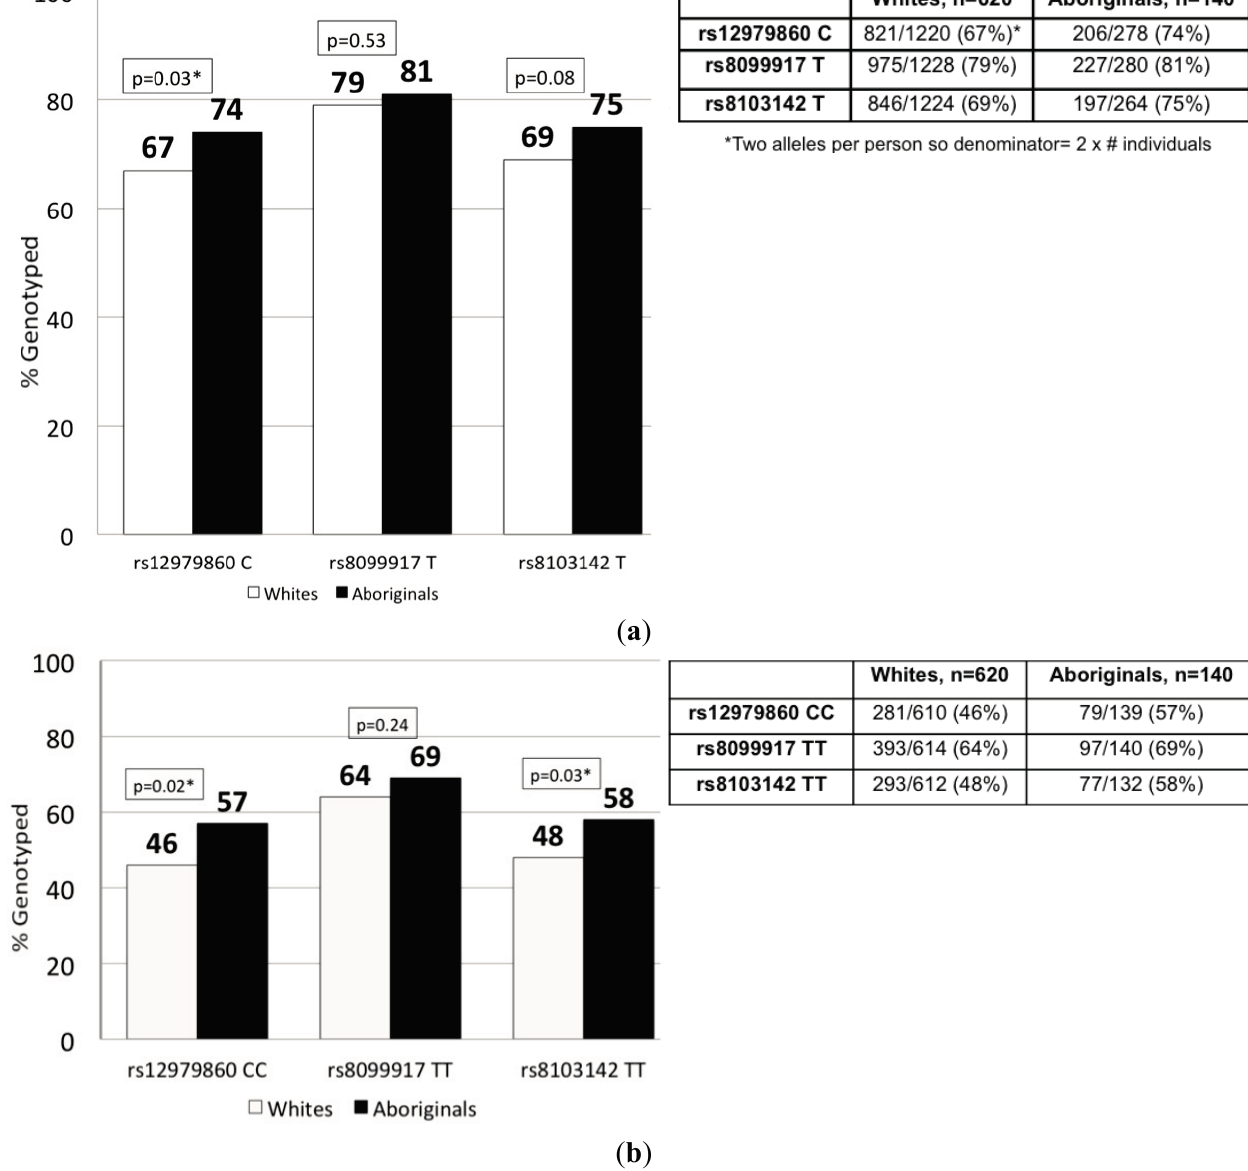
Figure 1. Distribution of favourable IFNL3 genotypes and alleles in Canadian-born Whites and Aboriginals: ( a ) Frequency of favourable IFNL3 alleles is higher in Aboriginals than Whites; ( b ) Frequency of favourable IFNL3 genotypes is higher in Aboriginals than Whites. * p <